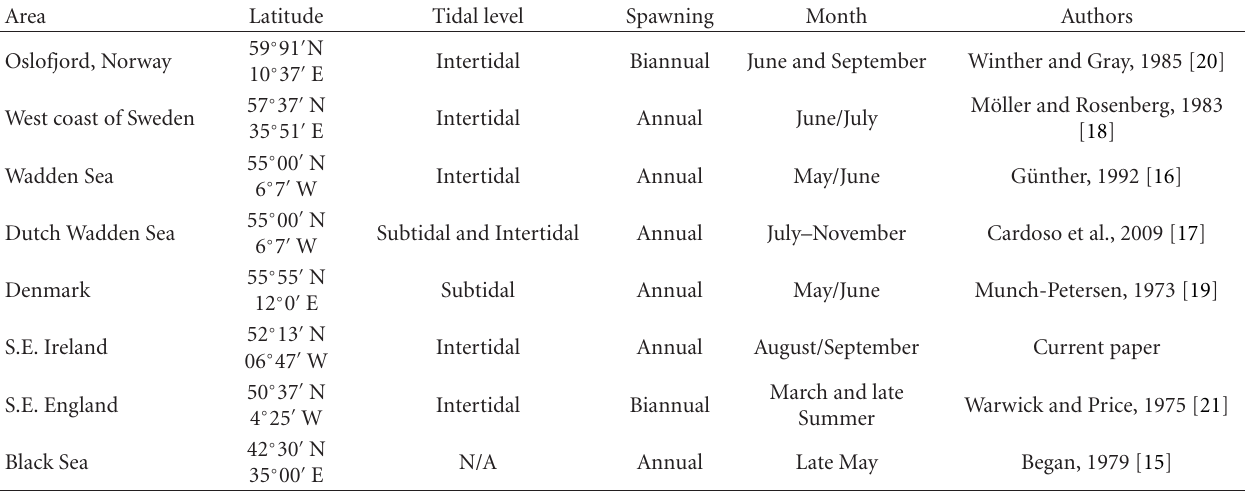
Table 2: The timing of spawning seasons, by latitude, of European Mya arenaria reported in the literature. Area